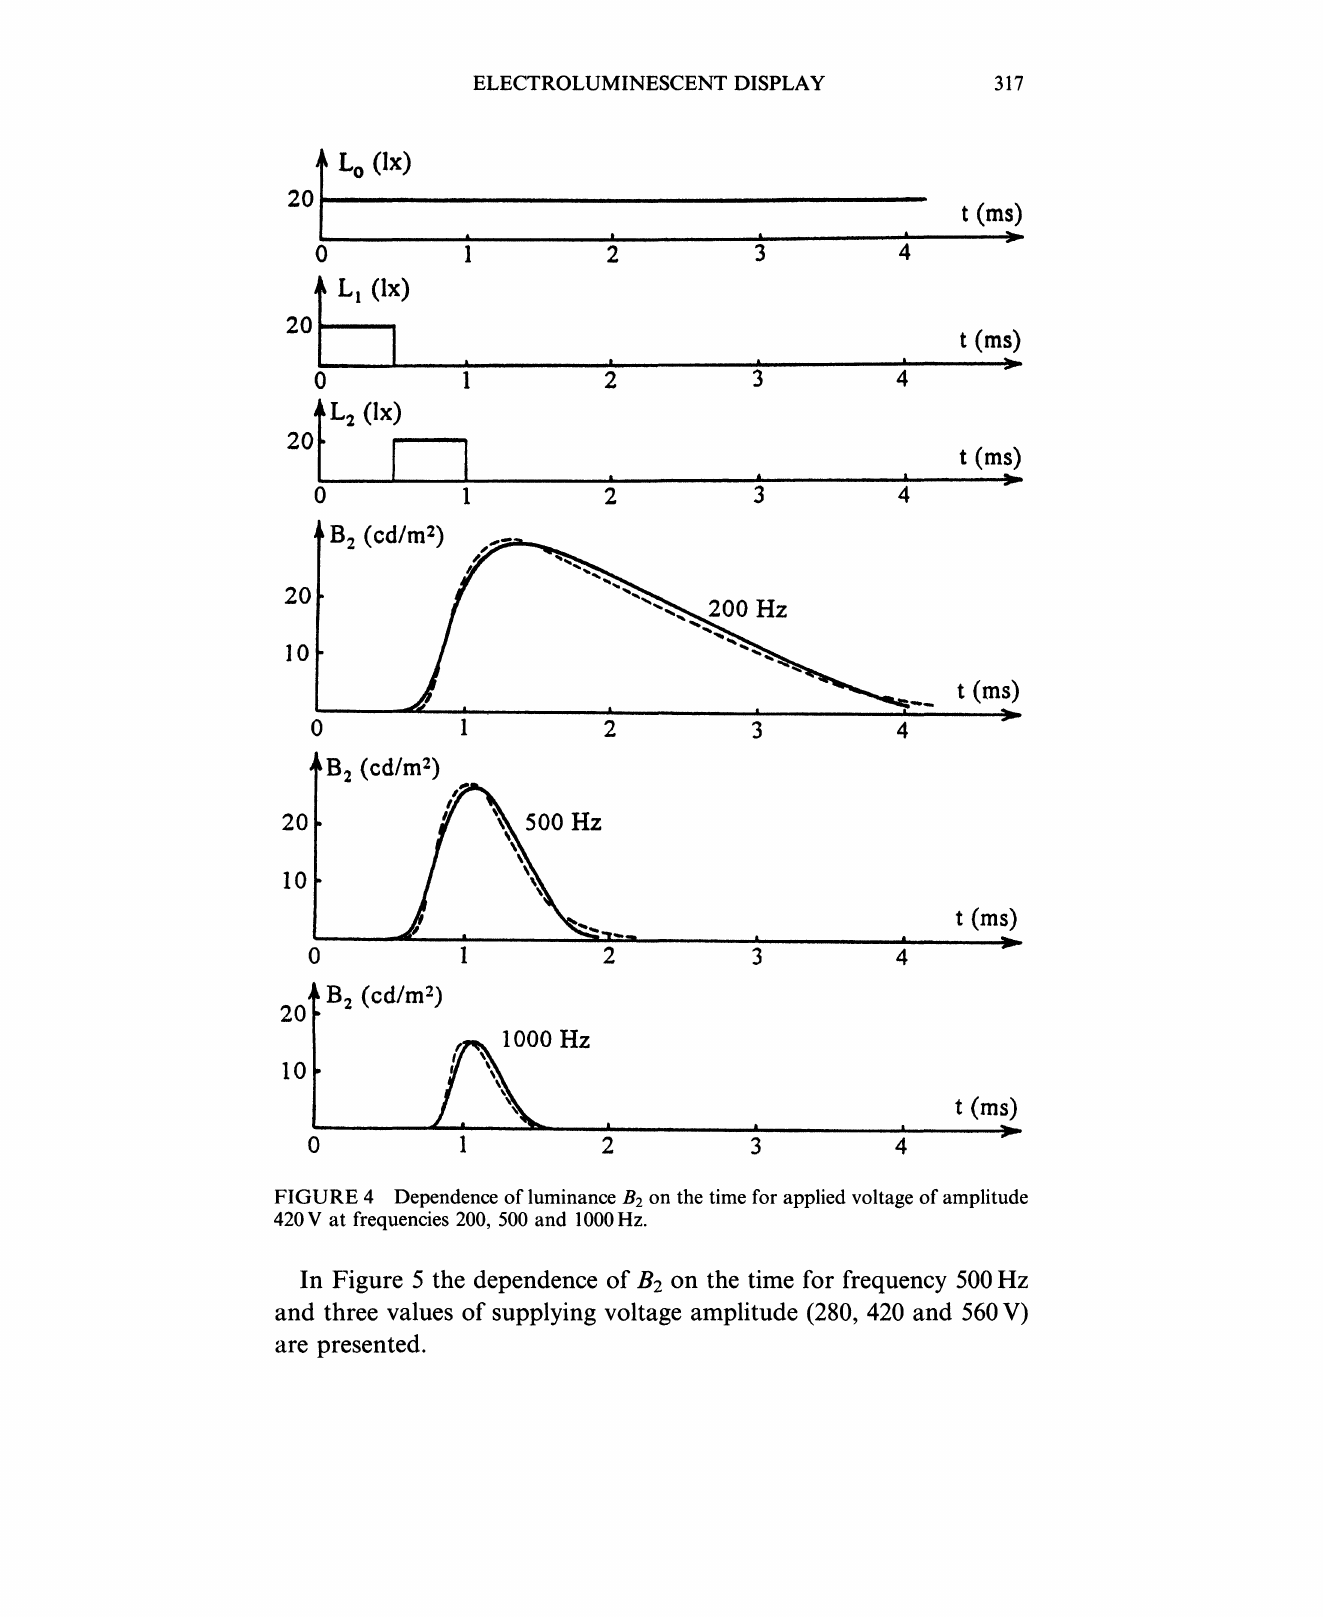
FIGURE 4 Dependence of luminance B2 on the time for applied voltage of amplitude 420 V at frequencies 200, 500 and 1000 Hz. In Figure 5 the dependence of B2 on the time for frequency 500 Hz and three values of supplying voltage amplitude (280, 420 and 560 V) are